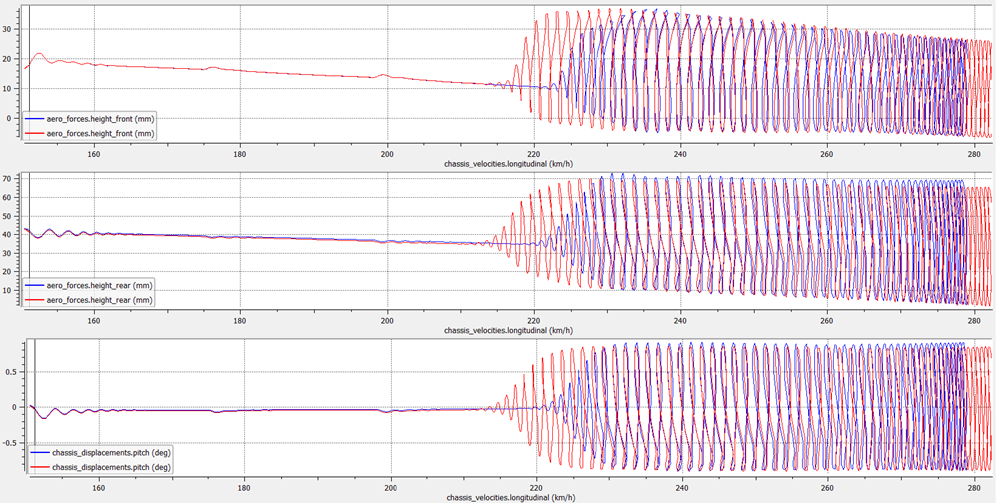
Figure 21. A stiffer bump stop at the rear axle (blue) basically delays the onset of porpoising from 210 to 220 kph for FRH ( top ), RRH ( center ), and pitch oscillation ( bottom ). Aero efficiency is also affected by a higher rear ride height on average.